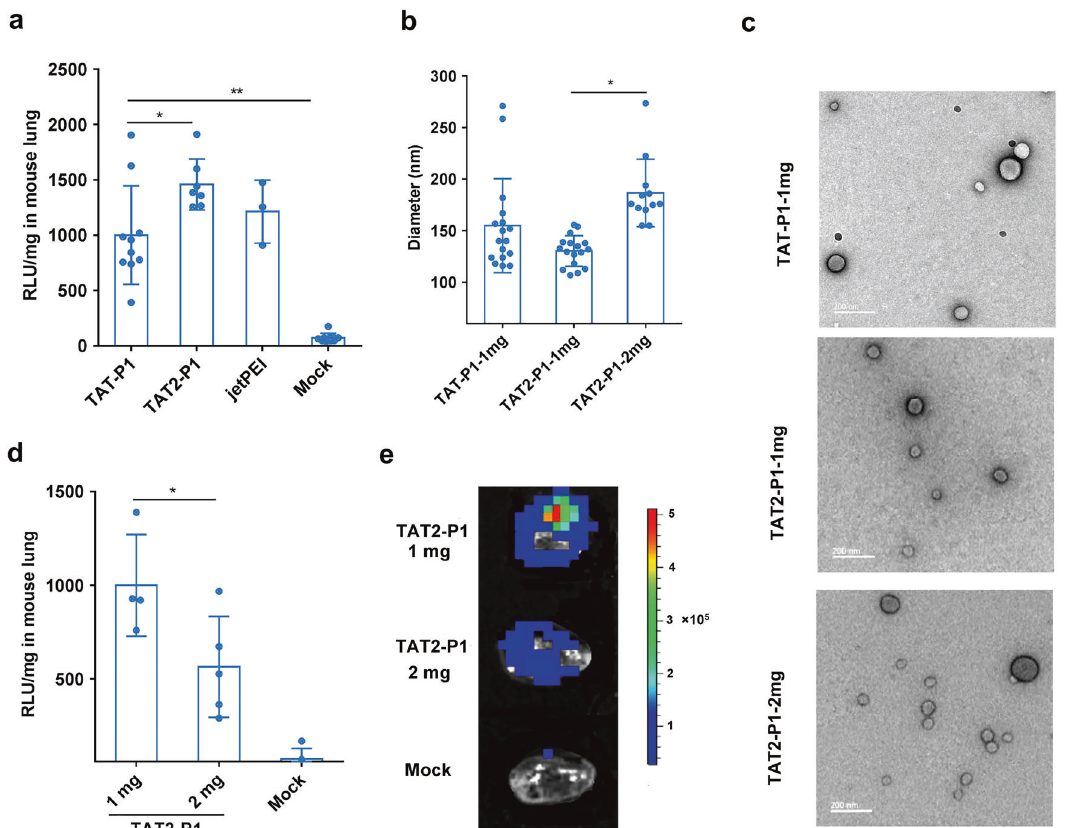
Fig. 3 Gene transfection ef fi ciency of TAT2-P1 in vivo. a The transfection ef fi ciency of TAT-P1, TAT2-P1, and in vivo jetPEI in mouse lungs. The pCMV-Luc was packaged by the indicated vectors with the weight ratio (4:1) of peptide:DNA. The luciferase expression in mouse lungs was measured at 24 h post transfection. Luciferase expression in mouse lungs was normalized to TAT-P1 (1000). Mock means mice treated with 5% glucose without pCMV-Luc. * indicates P < 0.05 and ** indicates P < 0. b Hydrodynamic diameter of nanoparticles of plasmid DNA packaged by indicated vectors. Sizes were measured by DynaPro Plate Reader. Data were presented as mean ± SD of six independent experiments. c The representative pictures of transmission electron micrographs (TEM) of nanoparticles. Peptides (1 mg ml − 1 or 2 mg ml − 1 for TAT2-P1-2mg) were mixed with equal volume of plasmid DNA (0.25 mg ml − 1 or 0.5 mg ml − 1 ) for measuring hydrodynamic diameter or for TEM negative staining. Scale bars, 200 nm. d The expression of luciferase in mouse lungs transfected